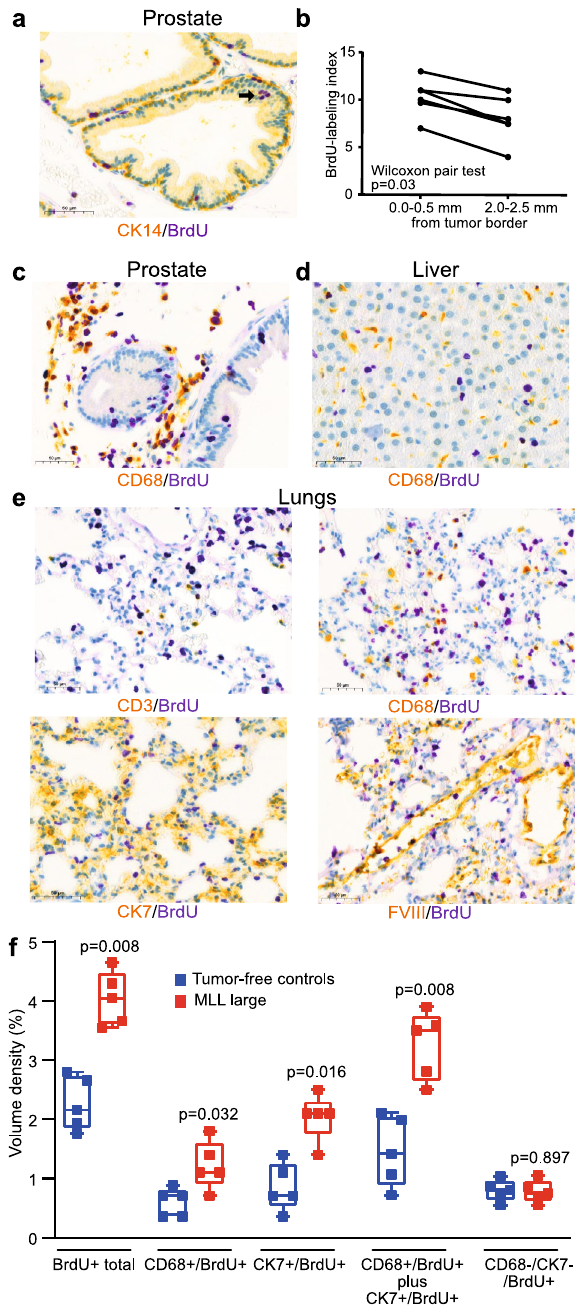
Figure 2. BrdU-labeling in various cell types in prostate, liver and lungs. ( a ) Sections from benign prostate glands in a rat with an intraprostatic MLL-tumor double-stained for BrdU (purple nucleus) and basal epithelial cell (CK14, dark yellow cytoplasm). Some basal CK14 + epithelial cells and some luminal epithelial cells (arrow) were BrdU +. ( b ) Graph showing the fraction (%) of BrdU-labeled benign prostate epithelial cells close to the MLL-tumor border (0–0.5 mm) or further way from the tumor border (2.0–2.5 mm). Prostate glands close to the tumor border had a significantly higher fraction of BrdU-labeling than more remote glands (Wilcoxon paired test). c ) Prostate tissue double-stained for BrdU (purple nucleus) and CD68 (yellow cytoplasm). Some infiltrating CD68 + cells were BrdU +. ( d ) Liver tissue double-stained for BrdU (purple nucleus) and CD68 (yellow cytoplasm) in an animal with an intra-prostatic MLL tumor. Most BrdU + cells appeared to be hepatocytes whereas CD68 + cells were seldom BrdU-labeled. ( e ) Lung tissue immune-stained for; (1) BrdU (purple nucleus) and CD3 (yellow cytoplasm), 2) BrdU (purple nucleus) and CD68 (yellow cytoplasm), (3) BrdU (purple nucleus) and CK7 (yellow cytoplasm), and (4) BrdU (purple nucleus) and factor VIII (yellow cytoplasm) in an animal with an intra-prostatic MLL tumor. Several different cell types in the lung including pneumocytes (CK7 +) were BrdU + . ( f ) Box plots showing volume densities (%) of total BrdU-labelled cells, BrdU + macrophages (CD68 + /BrdU +), BrdU + pneumocytes (CK7 + /BrdU +), the sum of BrdU + macrophages and BrdU + pneumocytes (CD68 + /BrdU + plus CK7 + /BrdU +), and other BrdU + cells (CD68-/ CK7-/BrdU +) in lungs of animals with MLL-large tumors or in tumor-free controls (Mann–Whitney U